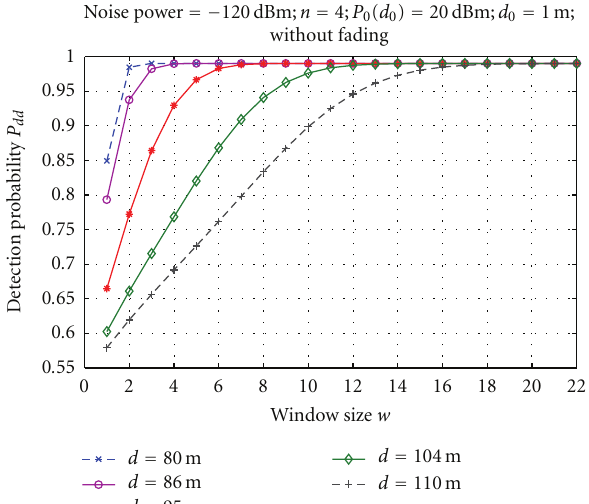
Figure 3: Detection probability P dd versus Window size.